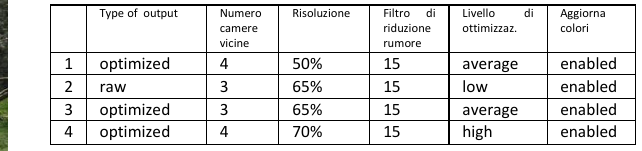
Table 2. changed parameters for the dense cloud